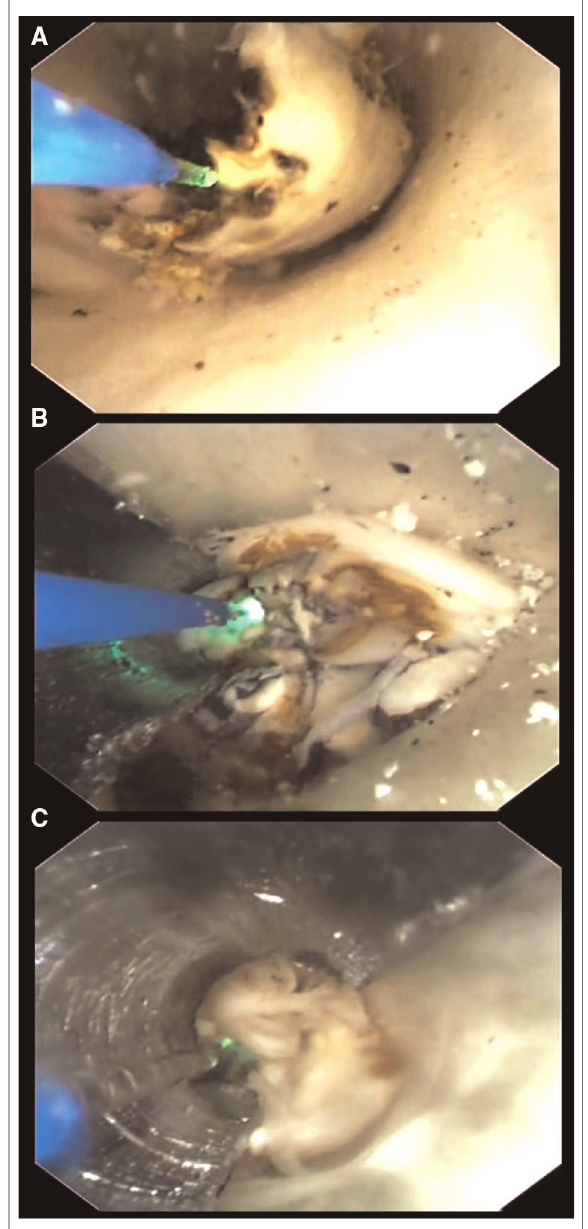
( Figure 4 ). Single-use laser fi bers with core diameters of 165 µm and 200 µm were used for TFL and Ho:YAG laser respectively.